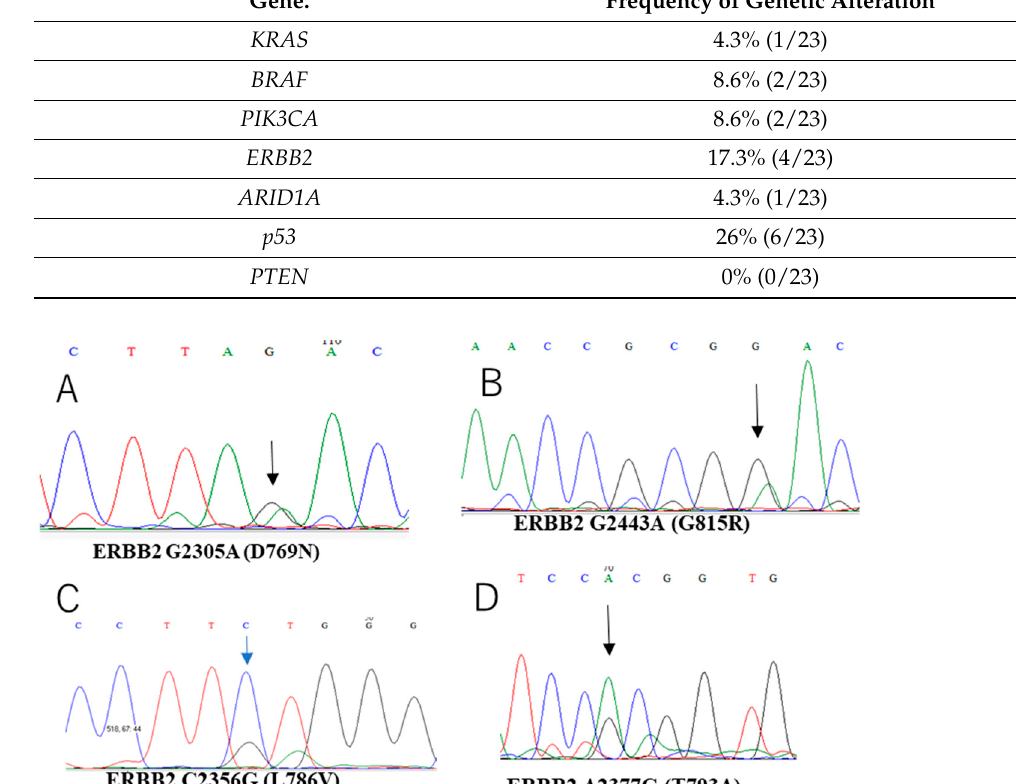
Figure 2. Chromatograms of ERBB2 mutation statuses in SMBTs. Each SMBT showed mutations ( A ) D769N (2305G>A), ( B ) G815R (2443G>A), ( C ) L786V (2356C>G), and ( D ) T793A (2377A>G) in the ERBB2 gene, respectively.